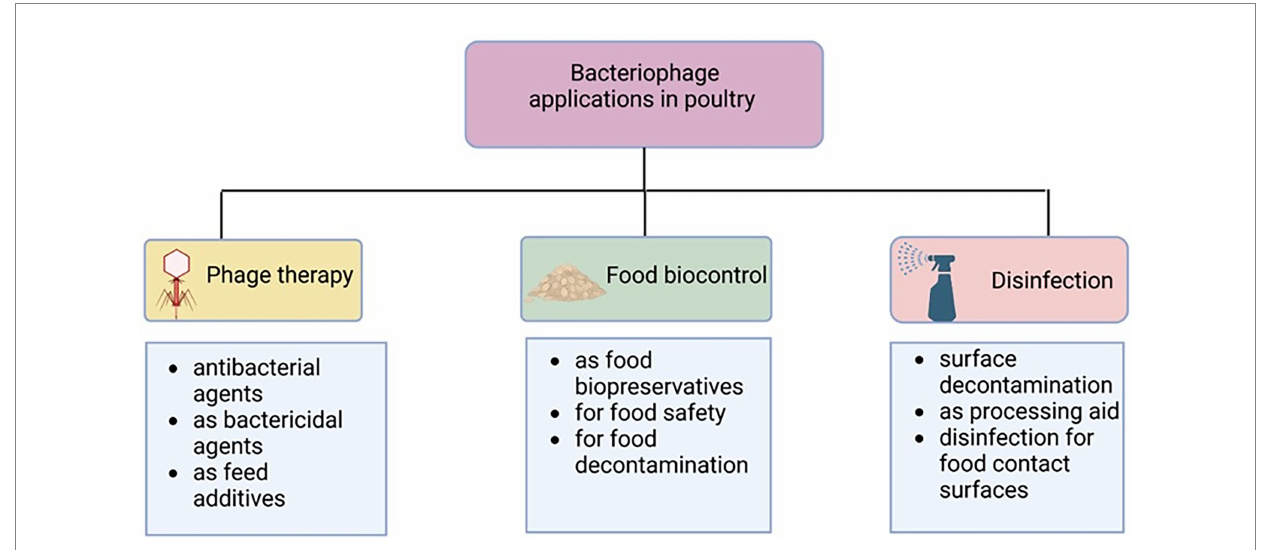
FIGURE 1 Bacteriophage uses in poultry industry. Created with